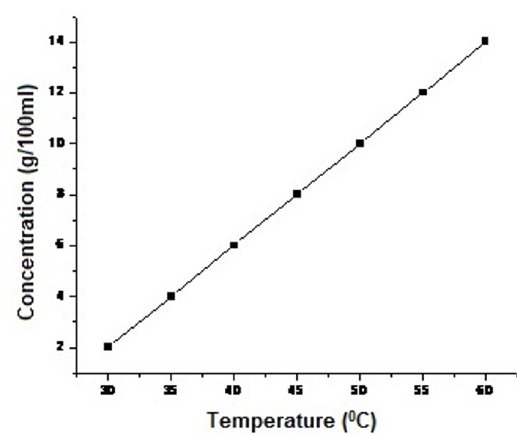
Figure 2. Solubility curve of MMTG